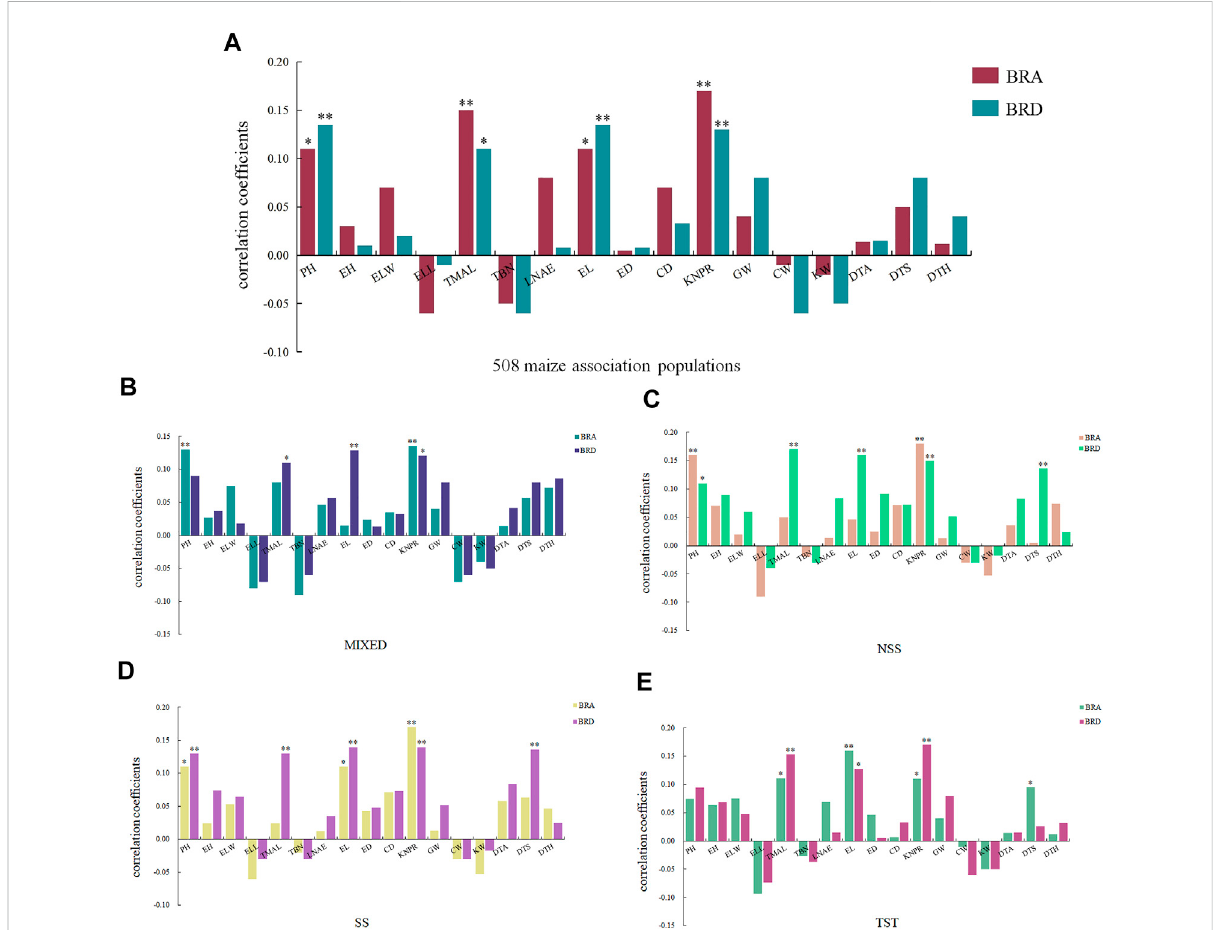
FIGURE 4 Correlation between BRA, BRD and 17 agronomic traits. (A) 508 maize association populations, (B) MIXED, (C) NSS, (D) SS, (E) TST. BRA , brace root angle; BRD , brace root diameter; PH , plant height; EH , ear height; ELW , ear leaf width; ELL , ear leaf length; TMAL , tassel maximum axis length; TBN , tassel branch number; LNAE , leaf number above ear; EL , ear length; ED , ear diameter; CD ,cob diameter; KNPR , kernel number per row; GW , 100-grainweight; CW ,cobweight; KW ,kernelwidth; DTA ,daystoanthesis; DTS ,daystosilking; DTH ,daystoheading.*representsasigni fi cant differences at the 0.05 level; *** represents signi fi cant differences at the 0.01